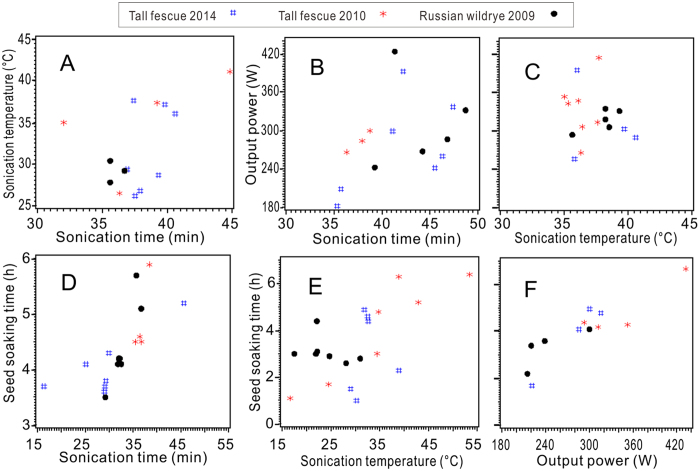
Scatter plots show the stationary points of the optimal models related to sonication temperature with sonication time (A), output power with sonication time (B) and with sonication temperature (C) and seed soaking time with sonication time (D), sonication temperature (E) and output power (F).